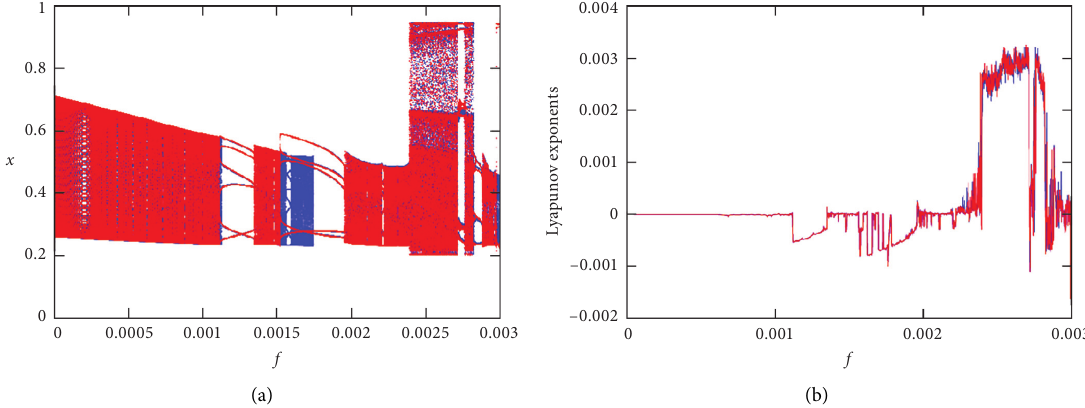
Figure 3: Bifurcation diagram and its corresponding Lyapunov exponent of nonlinear chemical reaction with ω � 0.0481, α � 0.0413, β � 0.0667, and g � 0. Bifurcation diagrams and its corresponding Lyapunov exponent are obtained by scanning the parameter f upwards (blue) and downwards (red).